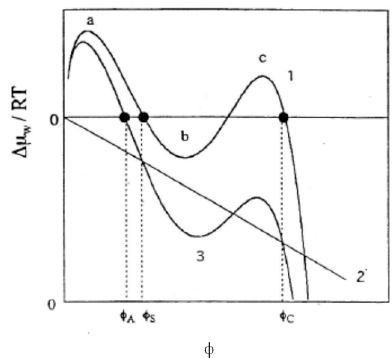
Figure 2. Calculated swelling curves in terms of Equation (11) in the case that the transition behavior disappears when ionic groups are introduced. ( ν V 1 / V 0 ) = 0.0058. χ 1 = 0.334 and χ 2 = 0.855. Curve 1 ( i = 0) represents two maxima a and c and one minimum b. Two black dots represent the volume fractions of the condensed ( φ C ) and the swollen ( φ S ) states in equilibrium with each other. Line 2 represents the last term of Equation (11) with i = 0.005. Curve 3 ( i = 0.22): a black dot represents the volume fractions of the equilibrium swollen volume fraction ( φ A ).